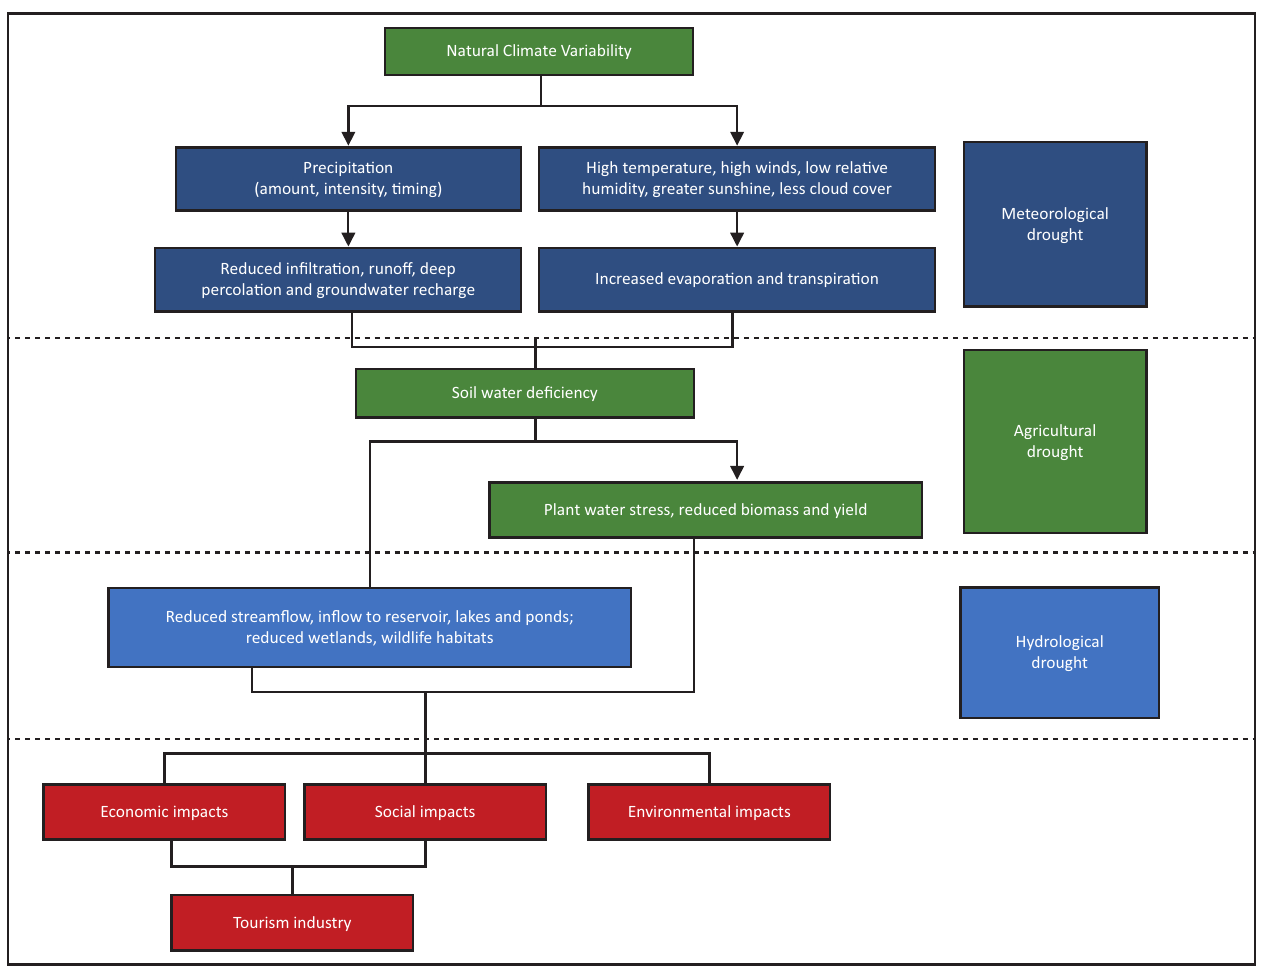
FIGURE 1: Drought propagation through the hydrological cycle.